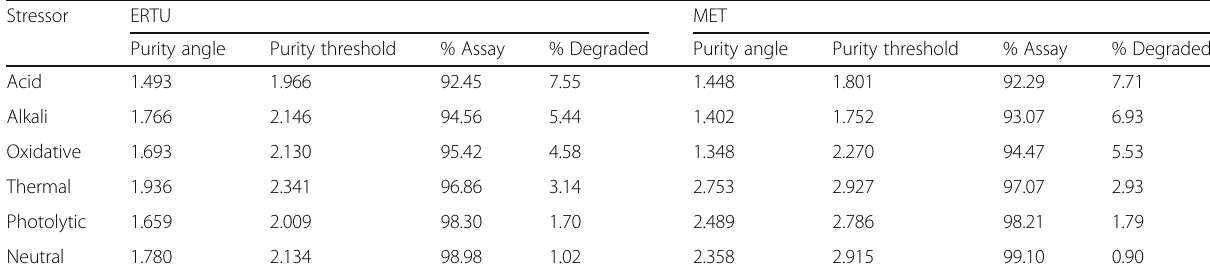
Table 2 Forced Degradation of ERTU and